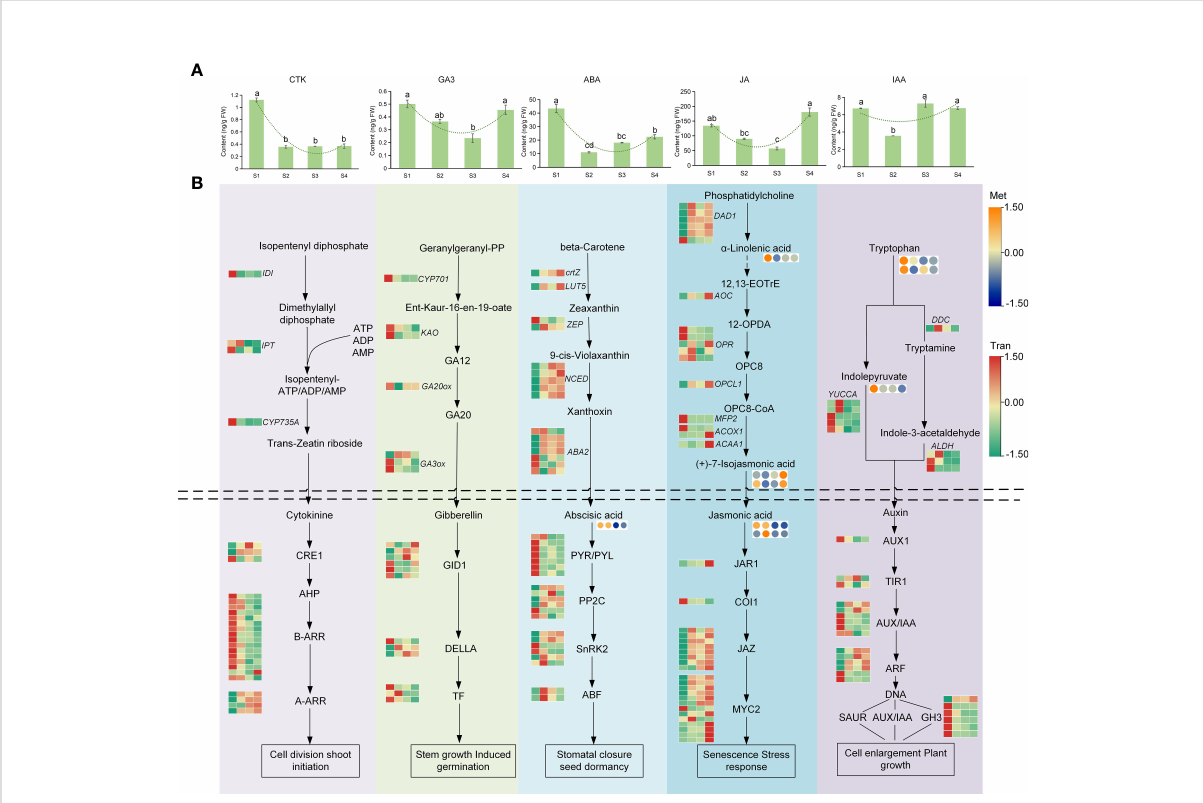
FIGURE 7 The anabolism of plant hormone during lettuce fl eshy stem expansion stages (S1, S2, S3, and S4). (A) The contents of CTK, GA, ABA, JA, and IAA in the four expansion stages (S1, S2, S3, and S4). Lowercase letters (A – D) in each column denote signi fi cant differences. (B) Analysis of the synthetic metabolic pathway of CTK, GA, ABA, JA, and IAA in the four stages (S1, S2, S3, and S4). Above the dotted line is the synthetic pathway, and below the dotted line is the metabolic pathway. The red (up-regulated) and green (down-regulated) in the heatmap represented gene expression, and the yellow (up-regulated) and blue (down-regulated) in the heatmap represented the metabolite